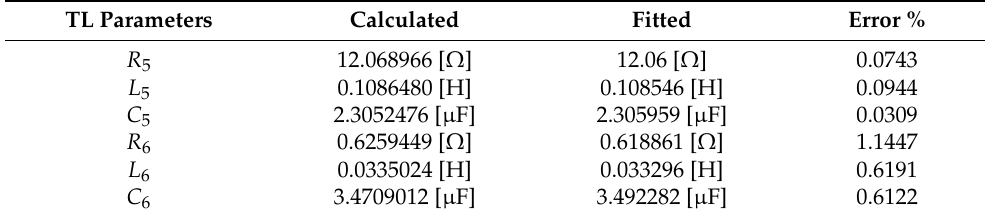
Table 9. The calculated and fitted parameters of the proposed model for Z 23